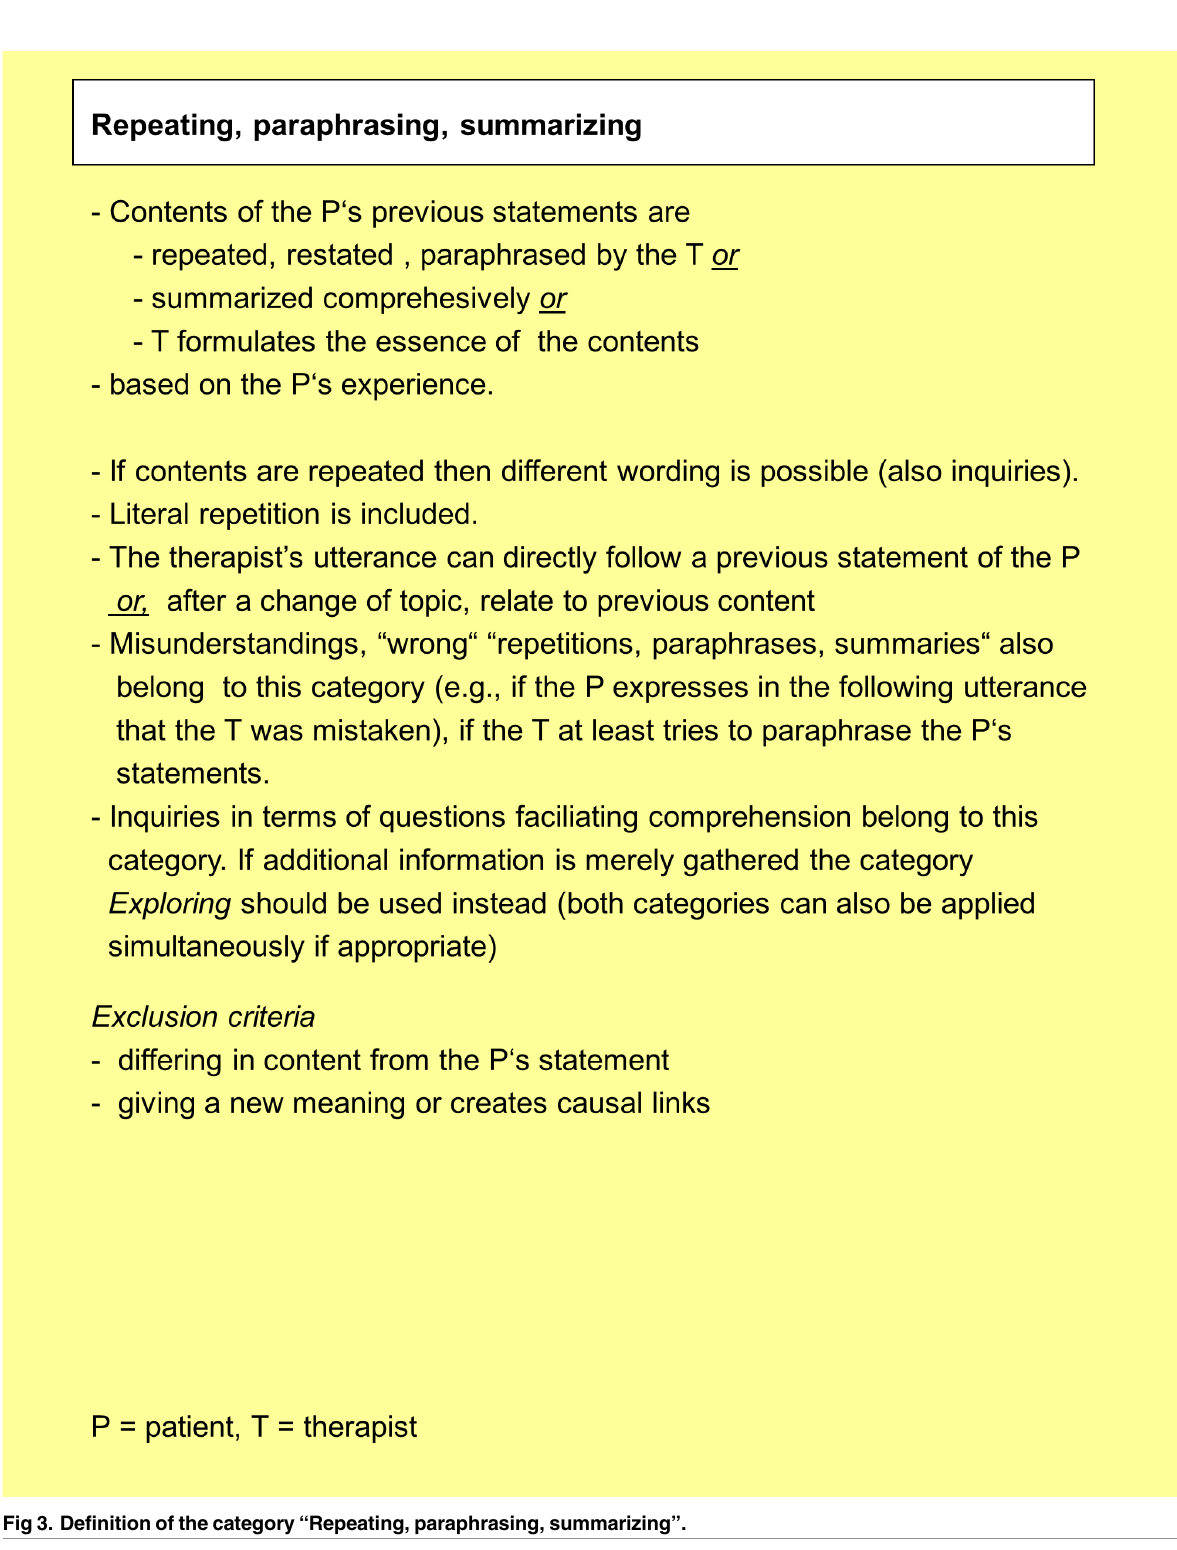
PLOS ONE | https://doi.org/10.1371/journal.pone.0182949 August 24,